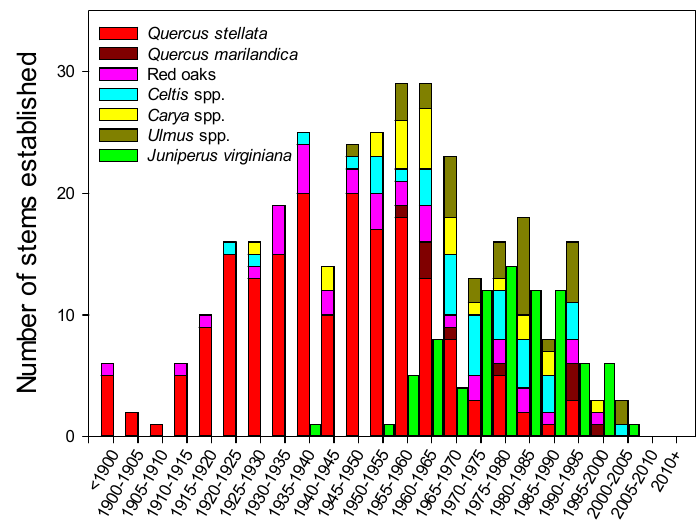
Figure 4. Major tree species associations measured in Cross Timbers forests of north-central Oklahoma presented in bi-decadal increments. All data were collected using increment cores at breast height such that each data point represents the 5-year period when the stem was recruited into the sapling size class. Juniperus virginiana were sampled separately from the other species and are offset for clarity of display.